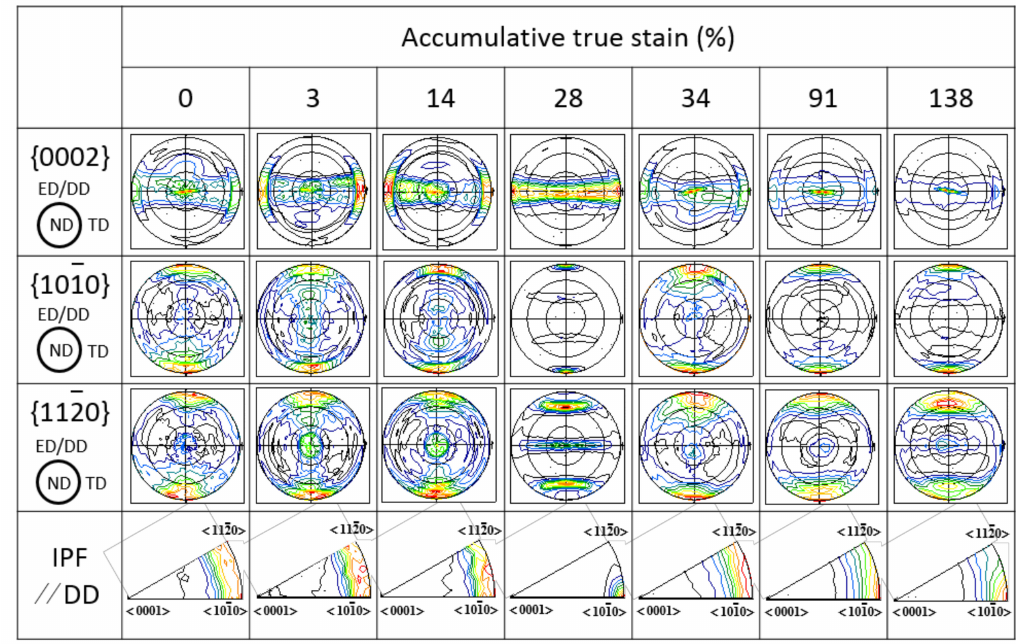
Figure 3. The pole figures (PF) and inverse pole figures (IPF) of as-extruded and as-drawn Mg wire with ATS of 3%, 14%, 28%, 34%, 91% and 138%.